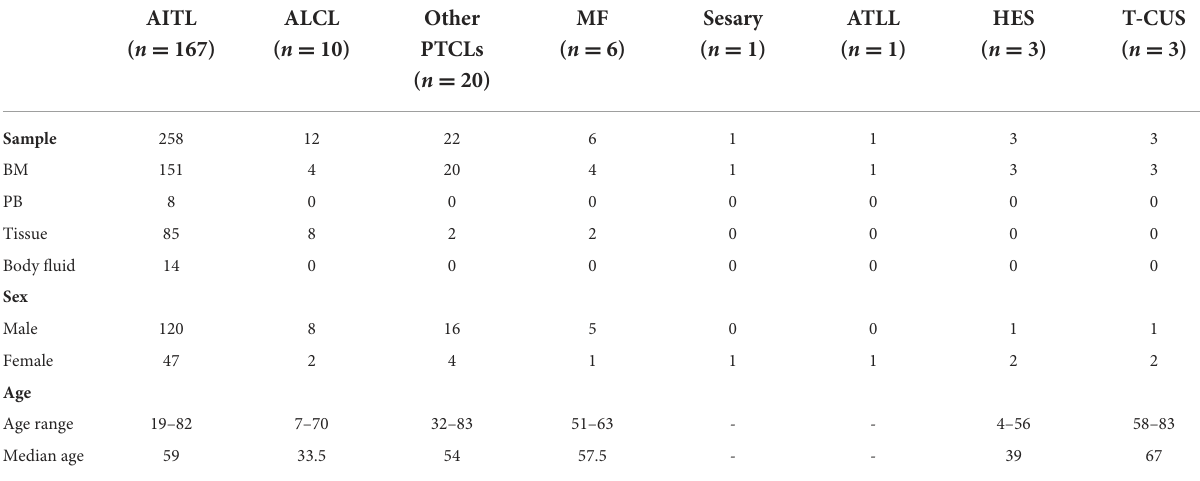
TABLE 1 Clinical information of patients.